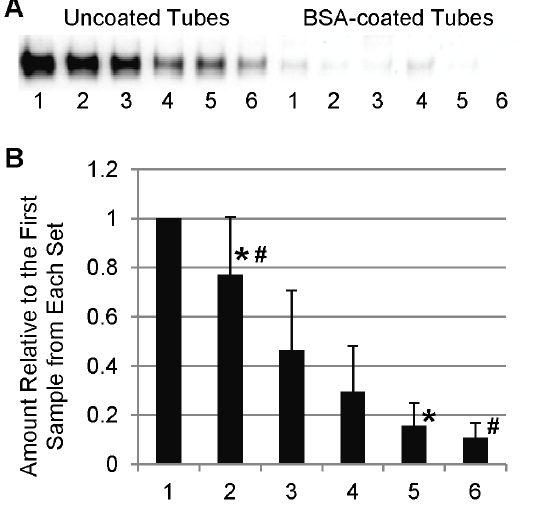
Figure 1. SP-D Adsorption to Polypropylene is Greatly Diminished by Coating with BSA. Western blotting detects the 43 kDa monomer of SP-D stripped from polypropylene tubes using Laemmli Buffer (A). 1 through 6 denotes the tube order during serial transfer. The amount of SP-D detected on uncoated tubes was quantified using ImageJ software (B). Columns with an asterisk (*) are significantly different (p # 0.05), as are columns labeled with the number sign ( # , p # 0.01).